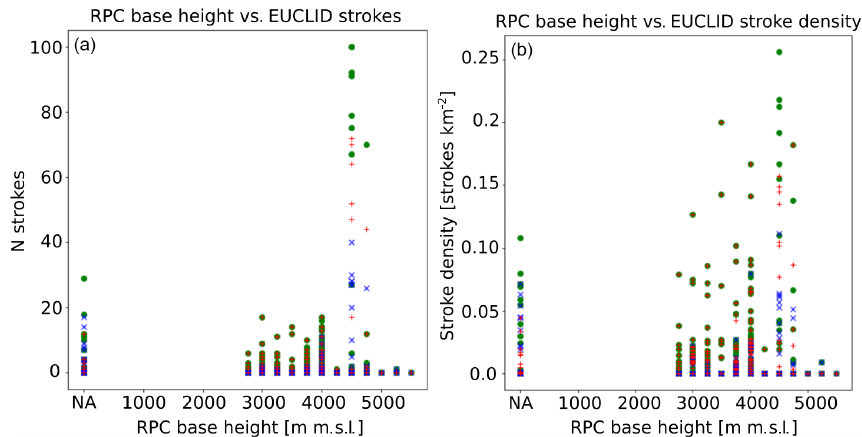
Figure 9. Scatter plot of RPC base height versus (a) number of EUCLID CG strokes within the TRT cell detected. (b) Density with respect to cell area. Blue crosses: CG + strokes; red crosses: CG − strokes; green dots: total lightning. NA means RPC base height not available.